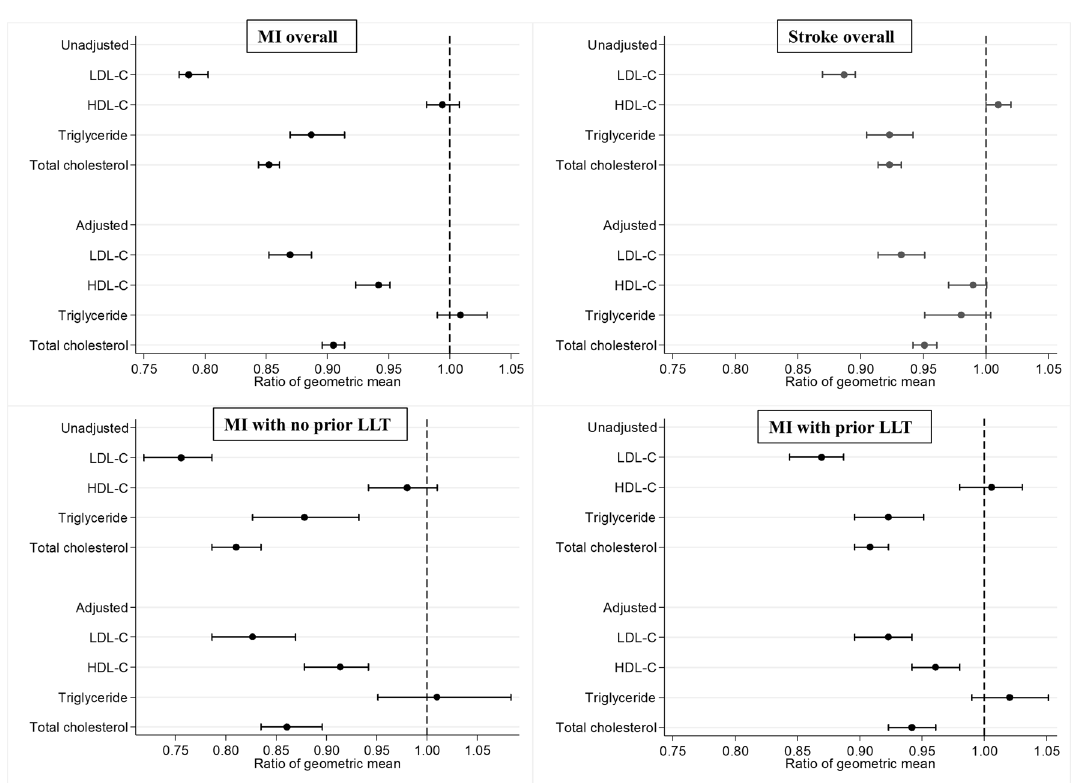
Figure 4. Ratio of geometric mean of lipid profile between patients in the prior cancer group and no cancer group (reference). Unadjusted and adjusted ratios of geometric mean of lipid profile divided into groups according to MI overall, stroke overall, MI with no prior LLT and MI with prior LLT. HDL-C: high density lipoprotein cholesterol; LDL-C: low density lipoprotein cholesterol; LLT: lipid lowering therapy; MI: myocardial